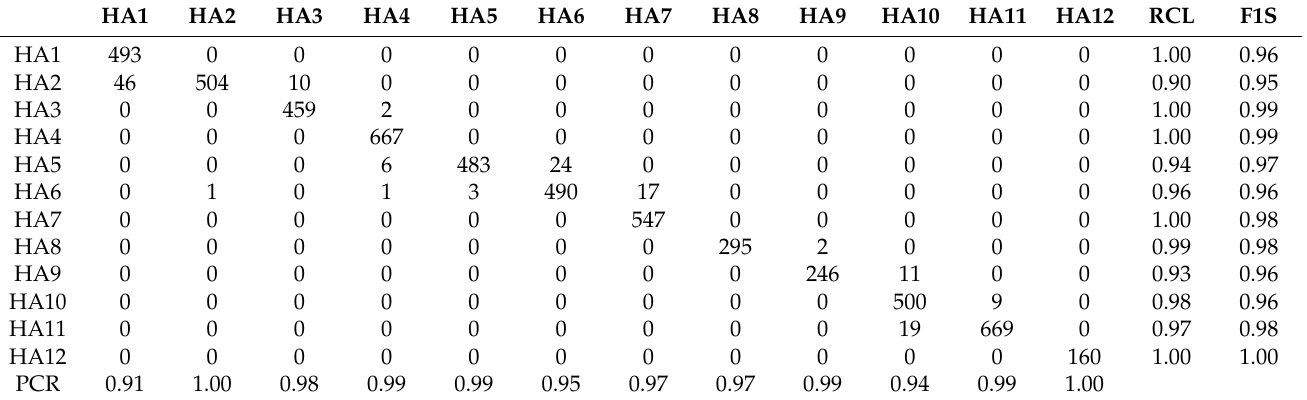
Table 5. Confusion matrix of model on PAMAP2 dataset.